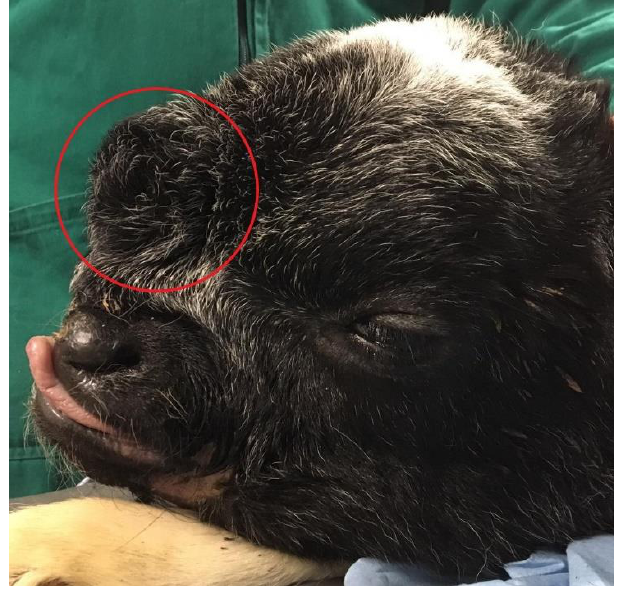
Figure 1. Profile view of calf’s head. The red circle indicates the fluctuant, sac-like protrusion covered with haired skin (suspected